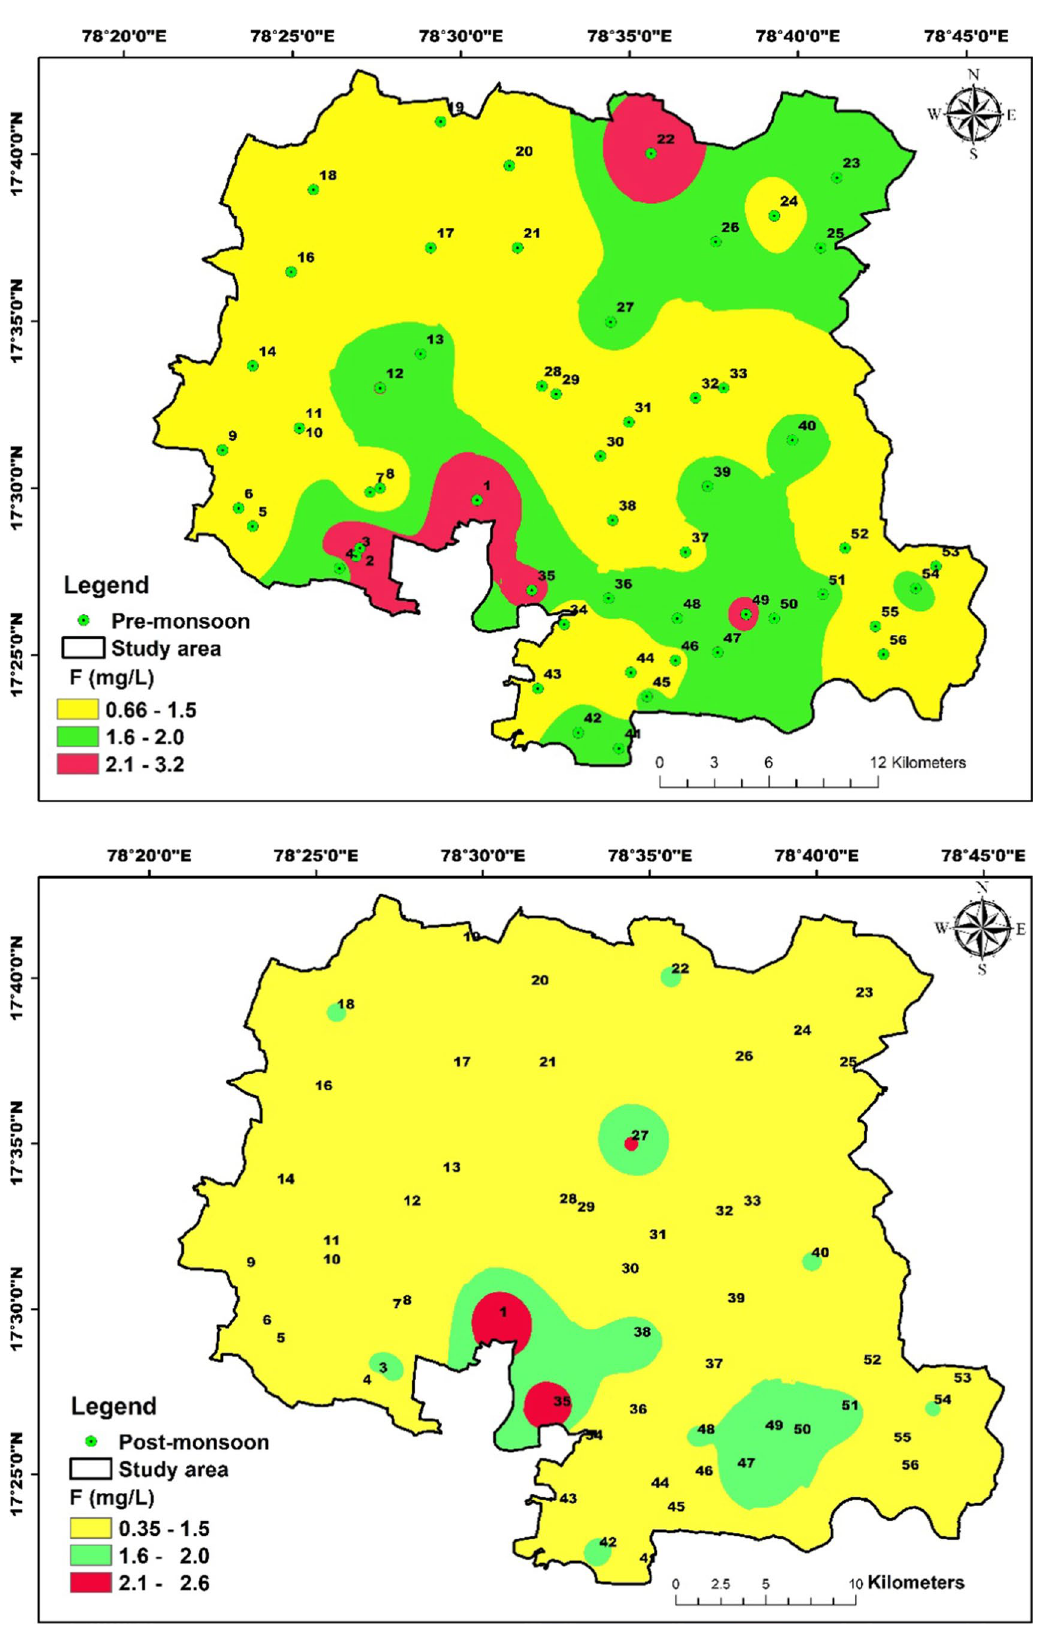
Fig. 8 Spatial distributions of fluoride concentration in the pre and post-monsoon